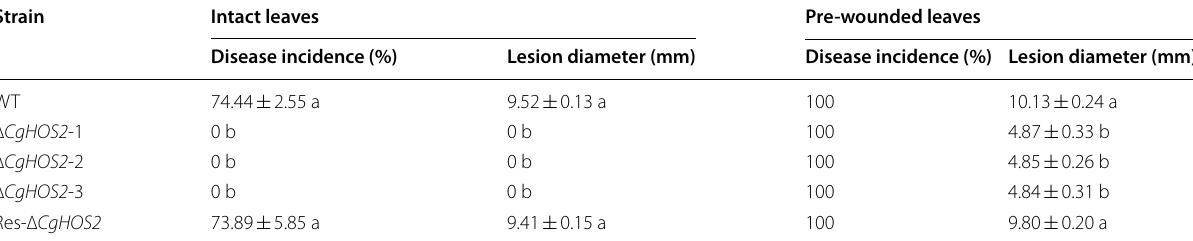
Table 1 Disease incidence and severity caused by C. gloeosporioides on rubber tree leaves